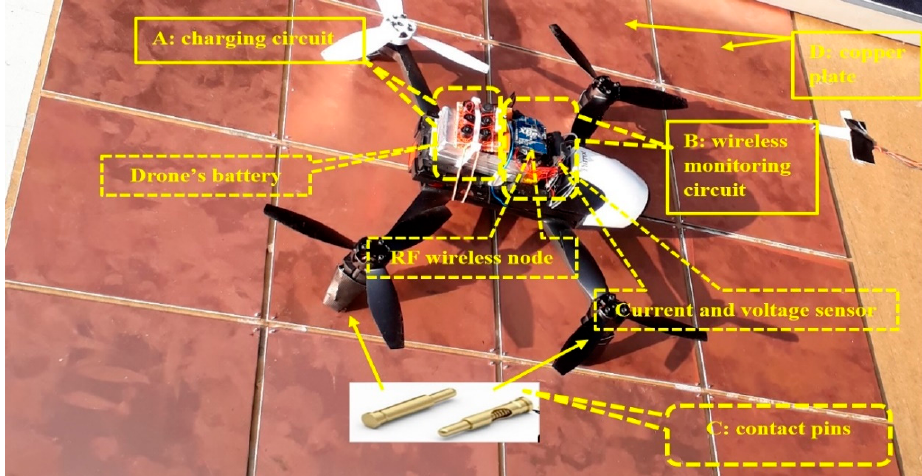
Figure 5. Experimental setup of the onboard system.